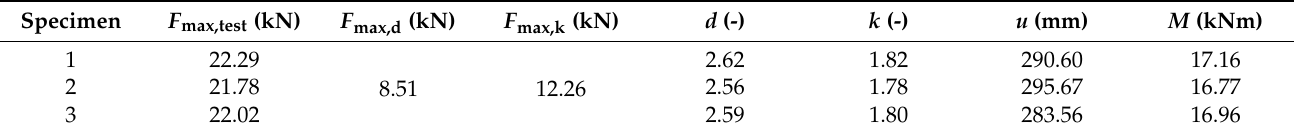
Table 6. Results of Experiment A, bolts and dowels; see Johanides 2022 [43].